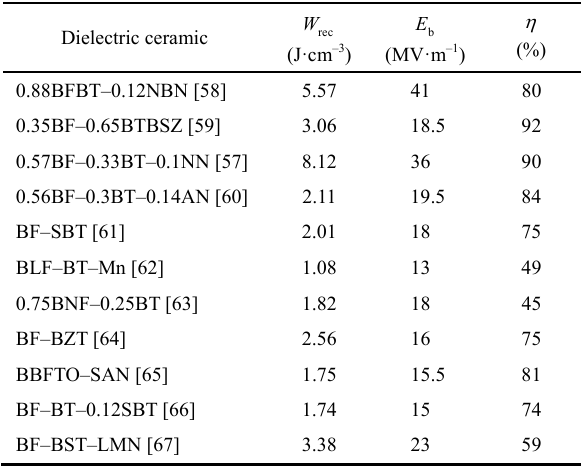
Fig. 10 (a–f) Nanodomain structures of 0.57BF–0.33BT–0.1NN ceramic. (g) P – E loops and d P /d E – E loops at 10 Hz. (h) Recoverable energy density and efficiency as functions of the applied electric field. Reproduced with permission from Ref. [57], © WILEY-VCH Verlag GmbH & Co. KGaA, Weinheim 2019. Table 4 Energy-storage properties of BF-based relaxor ferroelectric bulk